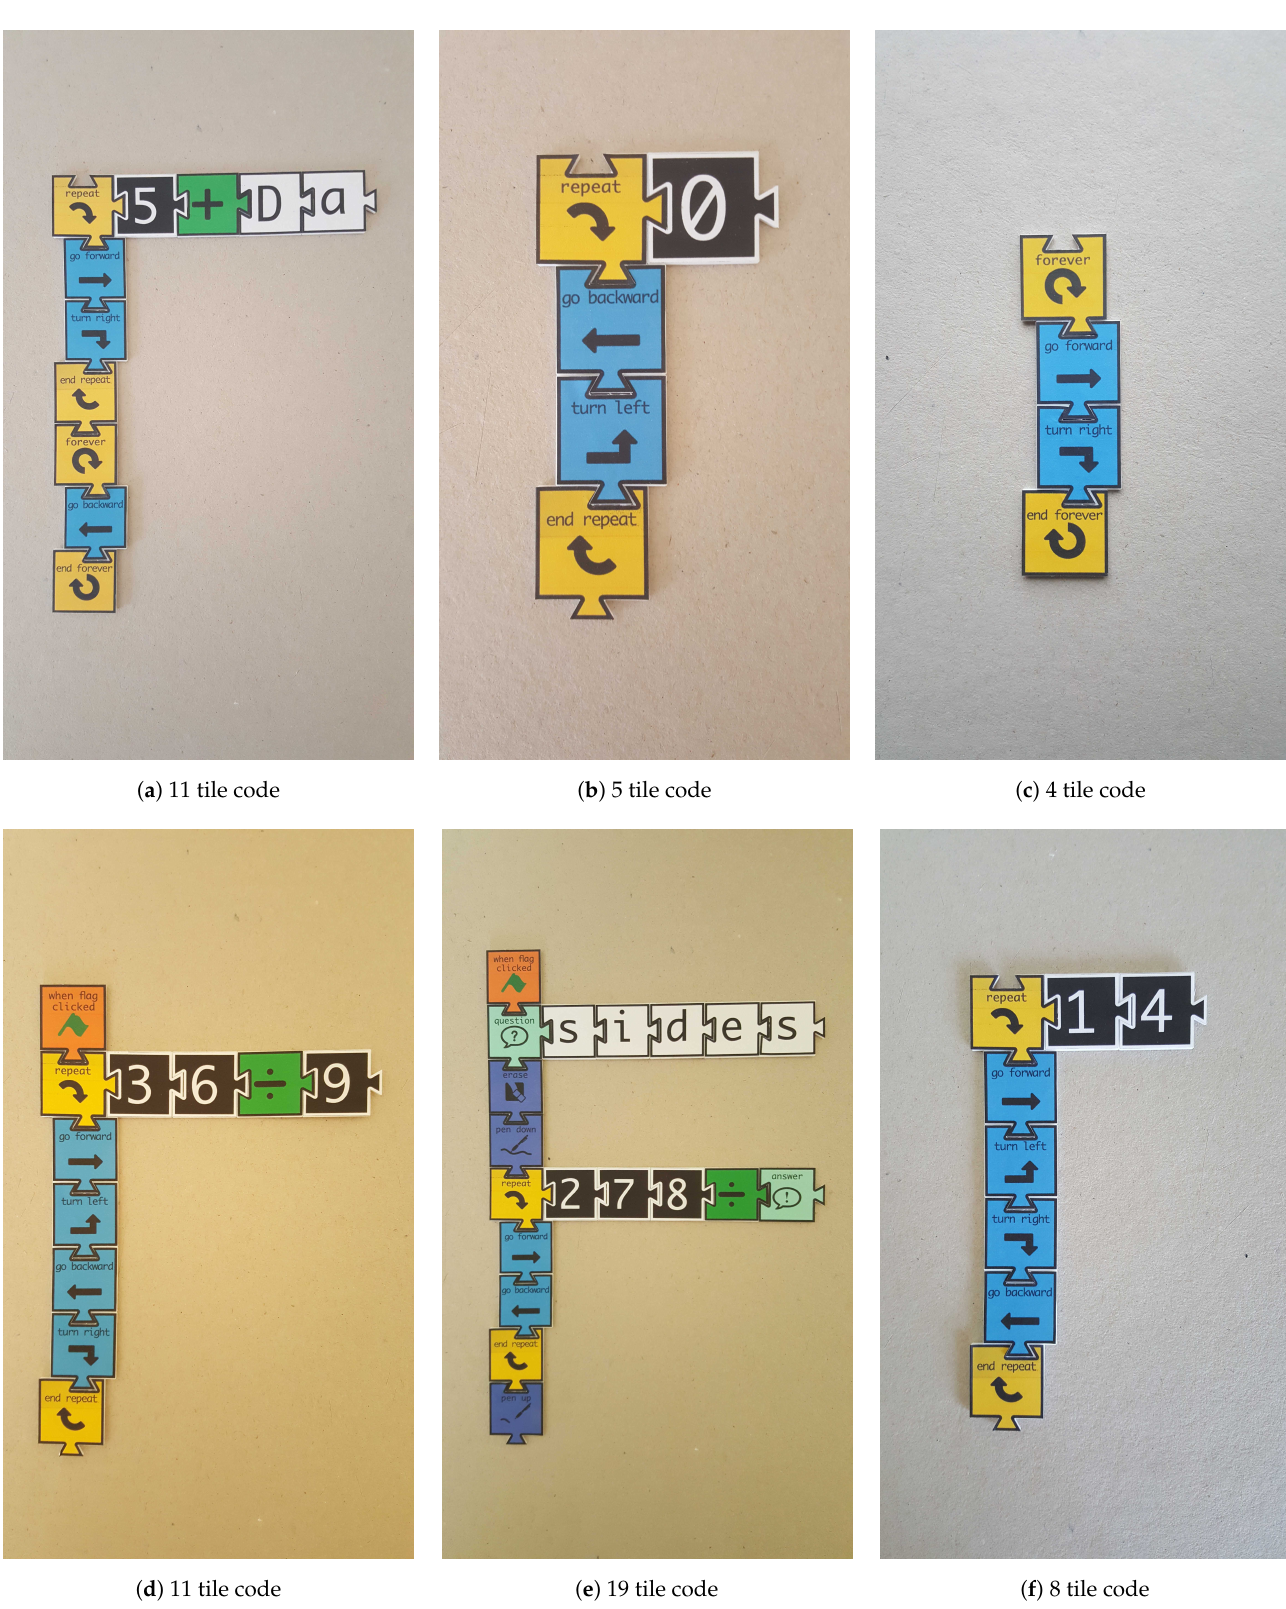
Figure A1. The six Tactode codes that compose the tactode_small test